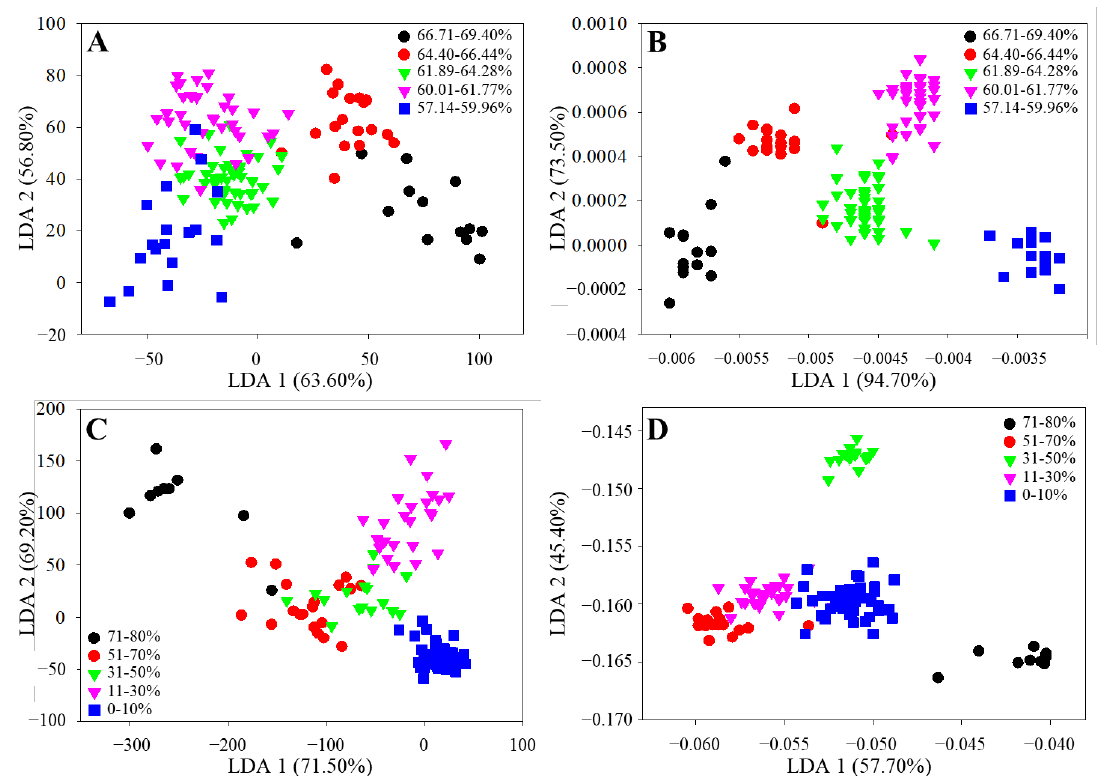
Figure 7. Linear discriminant analysis results for internal quality of sweet potatoes based on moisture (( A ) analysis by raw spectrum and ( B ) Savitzky–Golay derivative (S–G) preprocessed spectrum) and starch content (( C ) analysis based on raw spectrum and ( D ) standard normal variate (SNV) preprocessed spectrum).